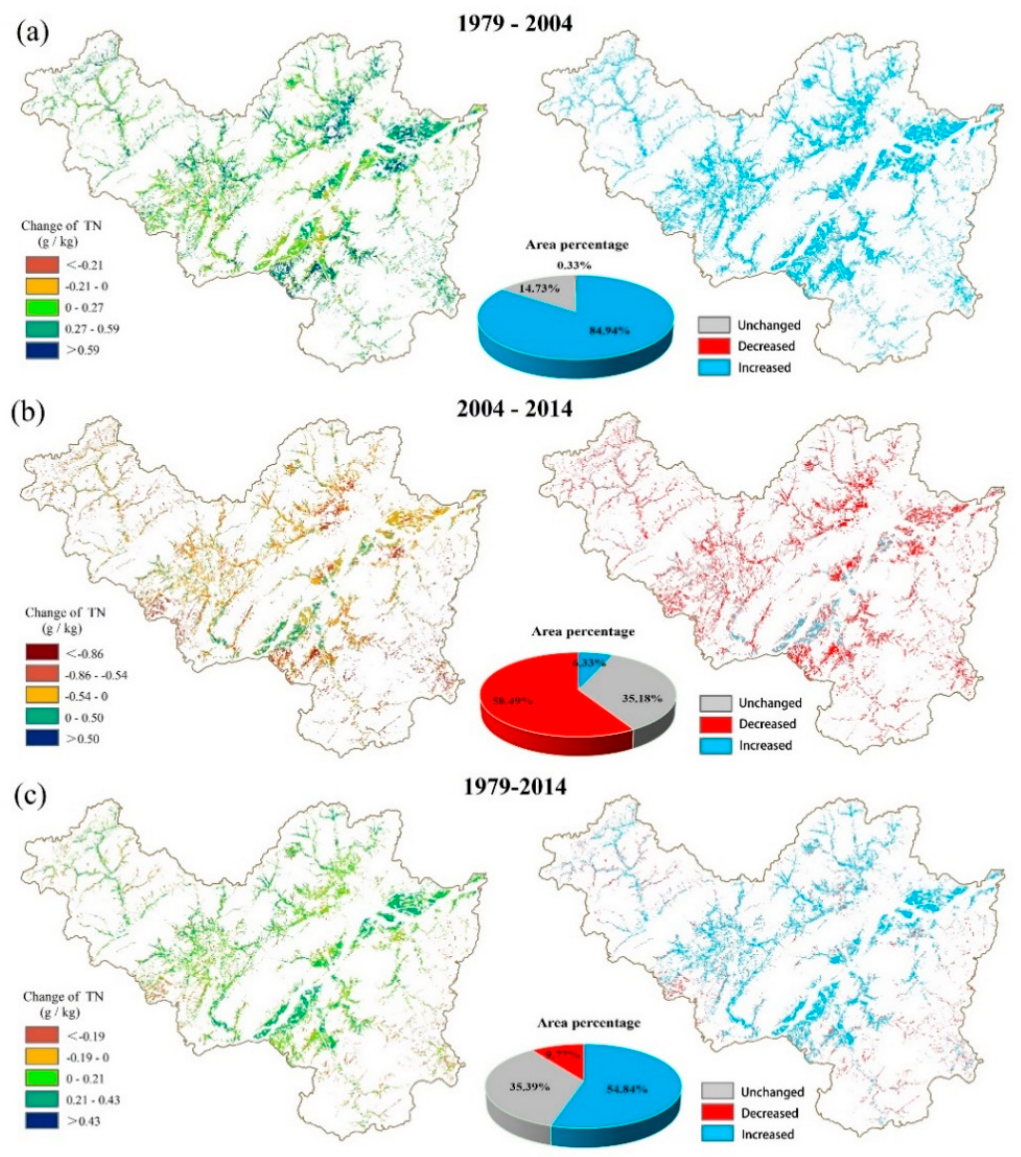
Figure 6. Spatiotemporal distributions of soil TN and the area percentage of TN level changes between 1979 and 2004 ( a ), 1979 and 2014 ( b ) and 2004 and 2014 ( c ). Table 6. Details of the farmland regions and geographic regions in Fuyang District.